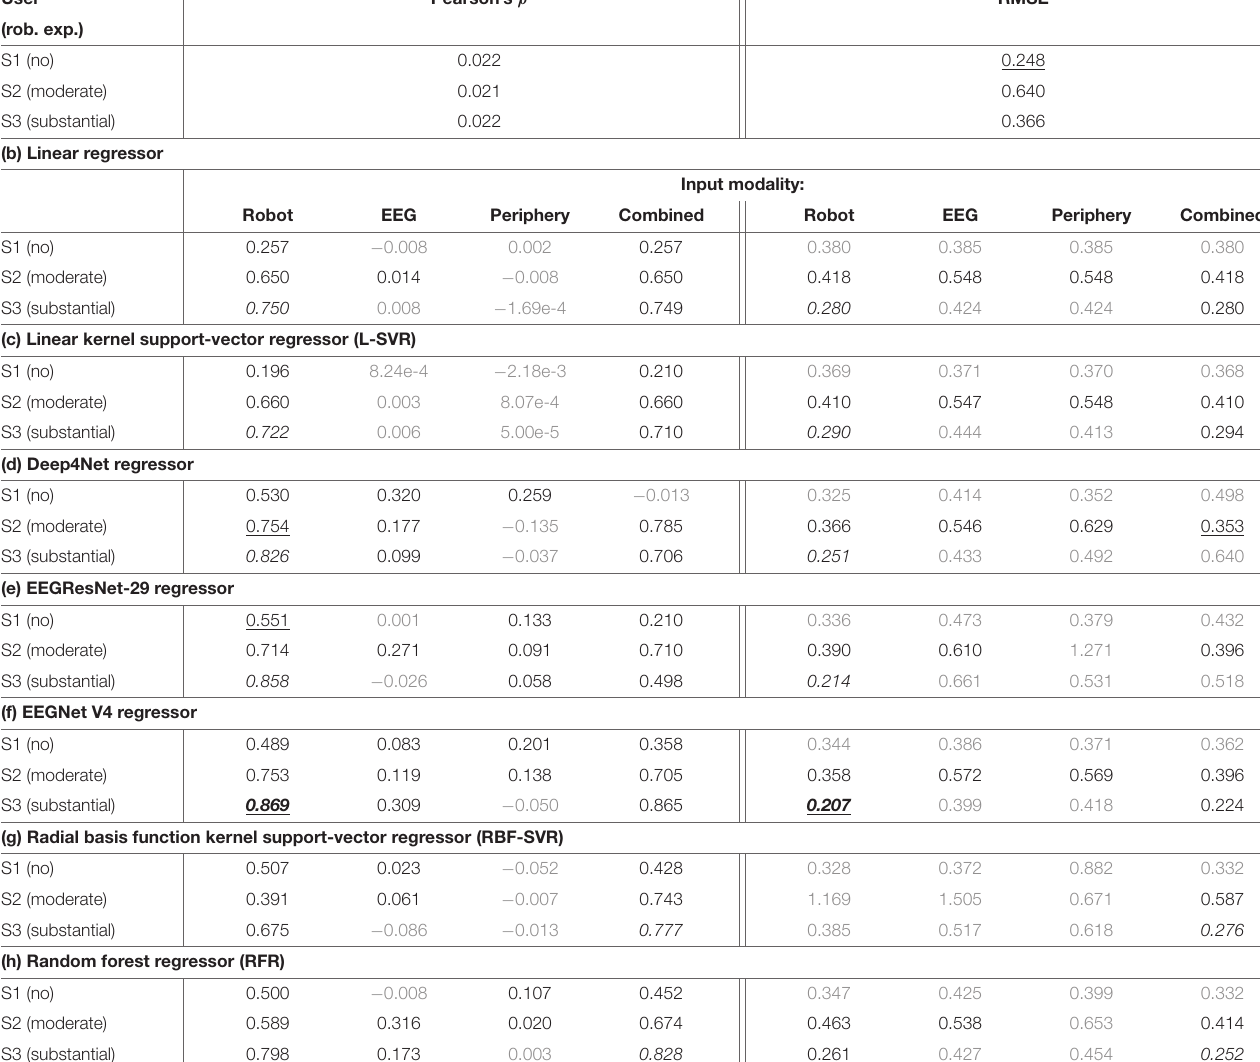
TABLE 3 | Regression test-set metrics for different data modalities. (a) Best of 10 6 random permutations of the training subjective ratings compared to the test subjective ratings User Pearson’s ρ RMSE (rob.